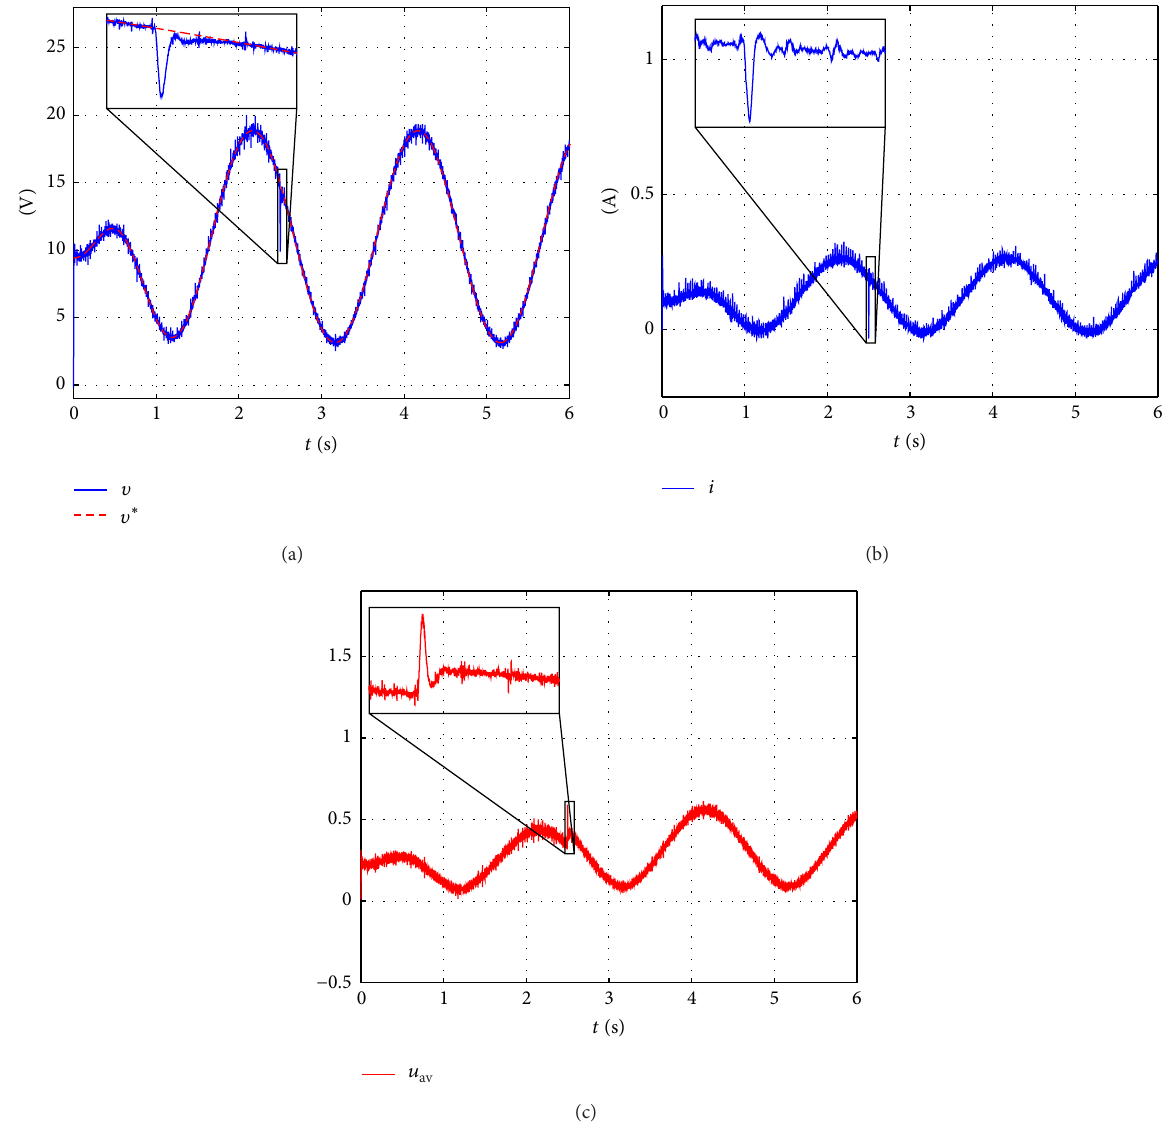
Figure 9: Case (iii) via